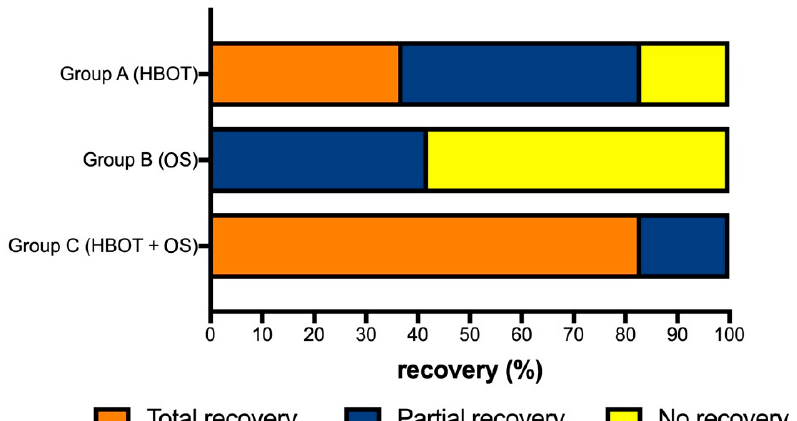
Figure 1. Comparison of hearing recovery among the groups.